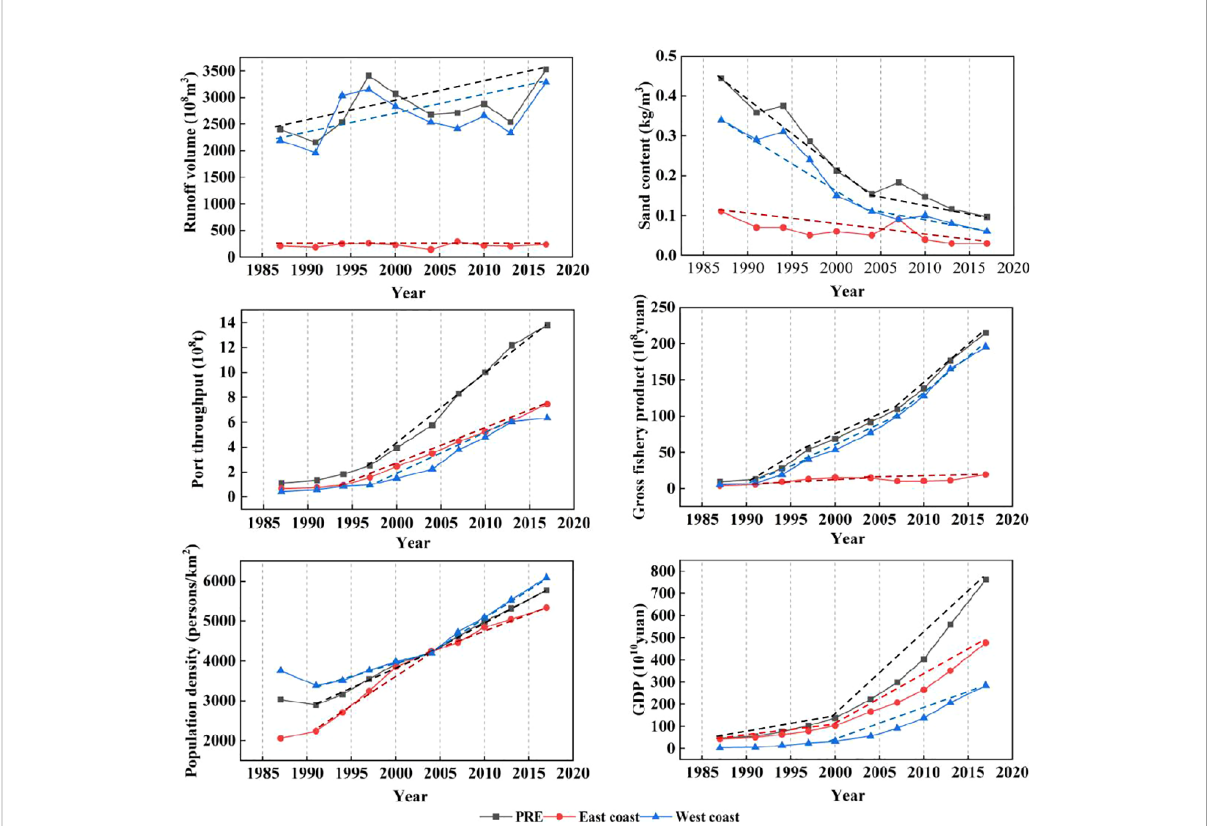
FIGURE 8 Trends of in fl uencing factors impact on coastline variation in the Pearl River Estuary during 1987-2017. The black, blue, and red dashed lines indicate the fi tted trends of the in fl uencing factors for the whole PRE, east coast in the PRE, and west coast in the PRE,